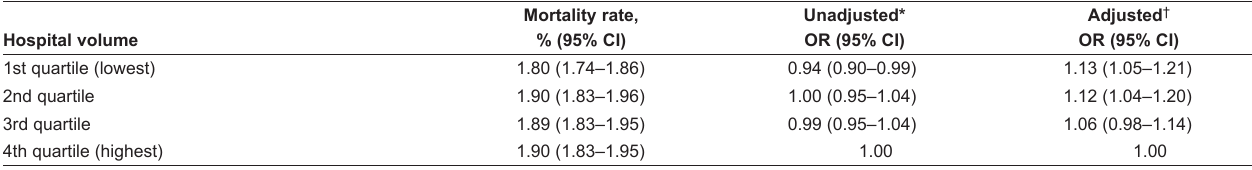
TABLE 2 Mortality rate, unadjusted and adjusted OR of mortality of diverticulitis patients according to hospital volume